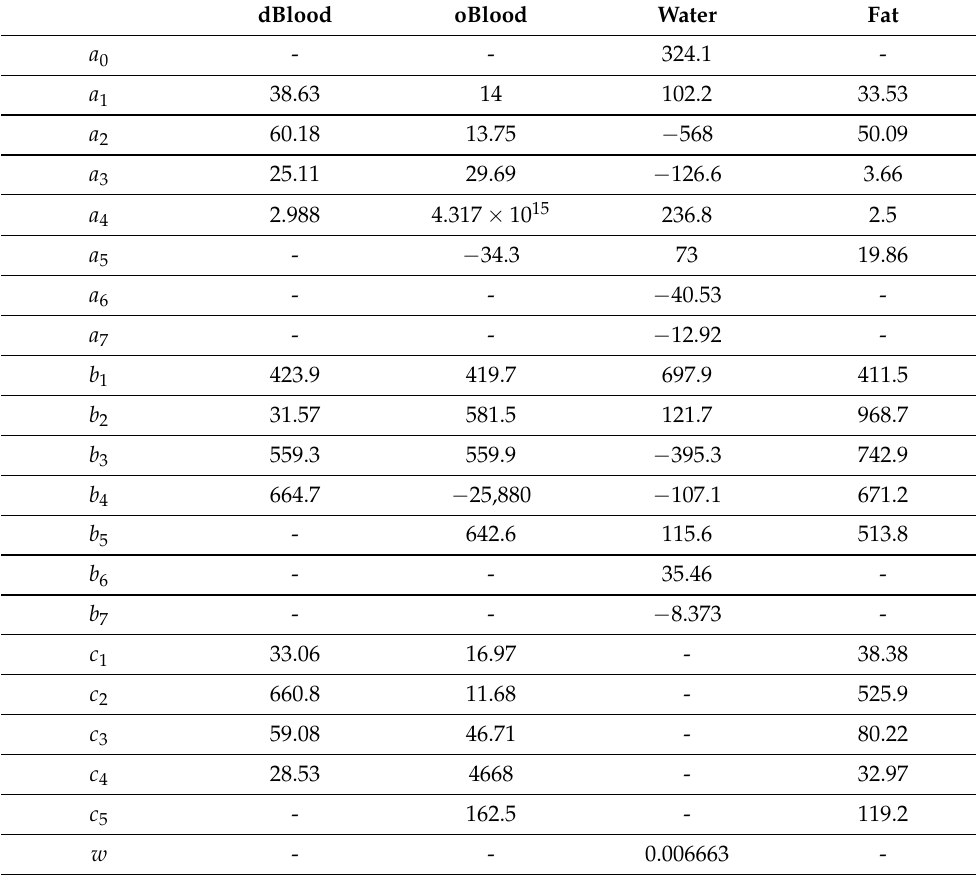
Table 2. Fitting parameters for the constituent’s absorption